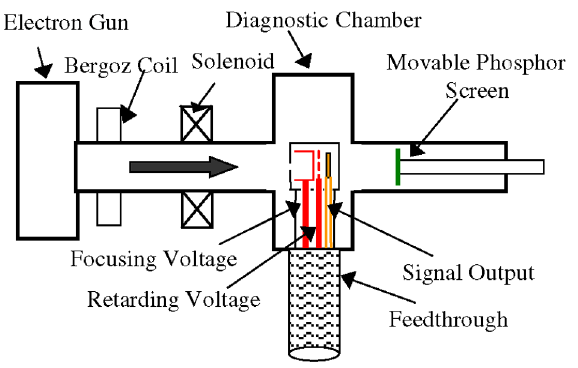
FIG. 3. (Color) The experimental setup.